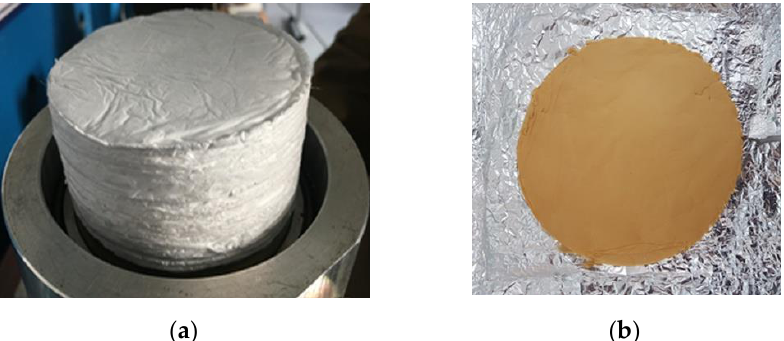
Figure 2. Acoustic sound absorption coefficient measurement. ( a ) Measurement setup in the laboratory; ( b ) Schematic of two-microphone impedance tube method.